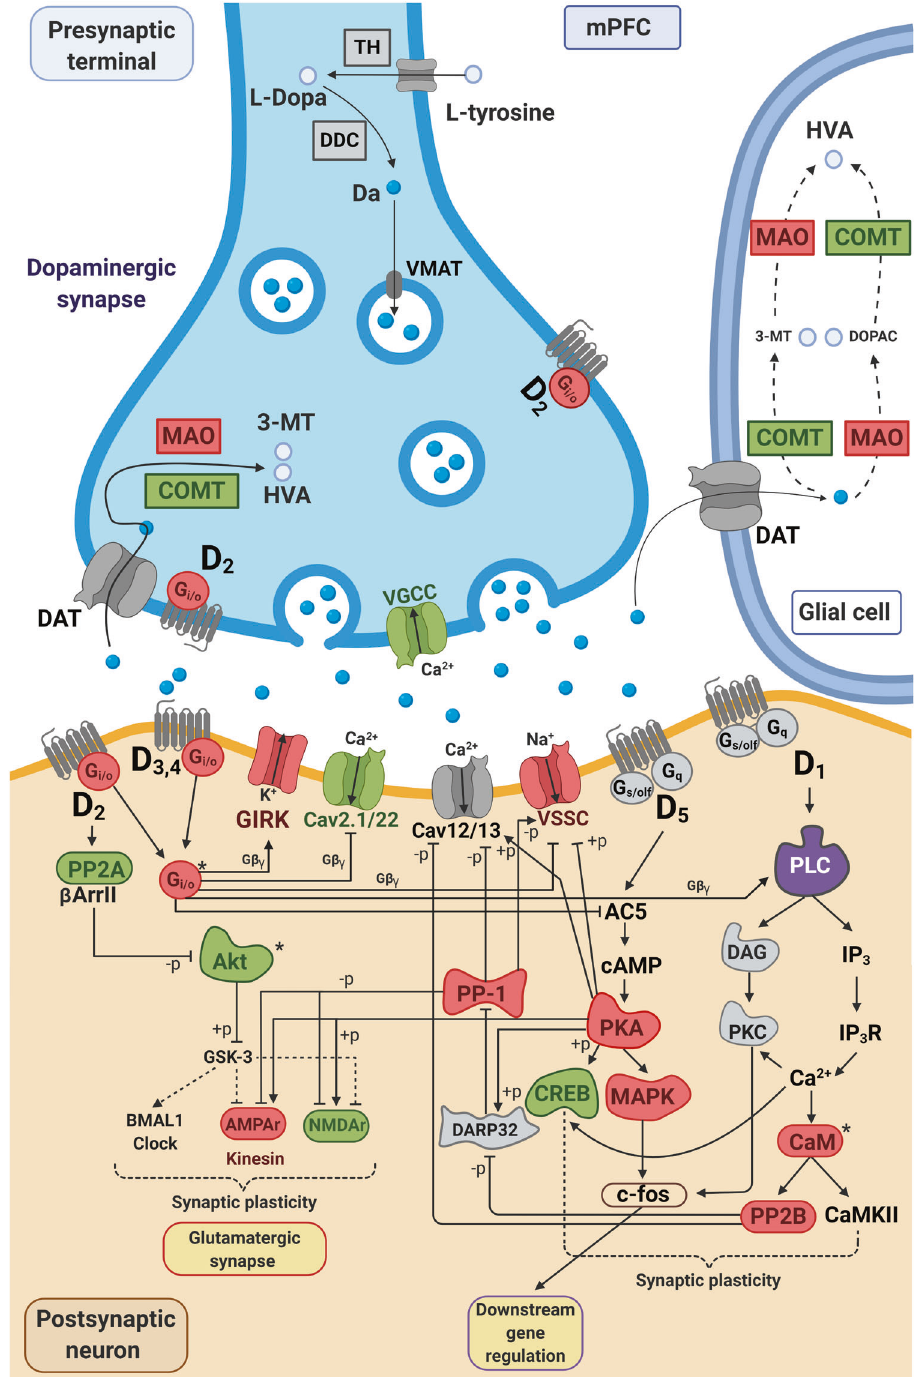
Fig. 4 Alterations in expression in the dopaminergic synapse in mPFC of Plcb1 + / − mice after cue-induced reinstatement of cocaine-seeking. Adapted from KEGG (Kyoto Encyclopedia of Genes and Genomes) pathways (mmu04728). Enriched pathway in differ- entially expressed genes in mPFC, 25 out of 131 genes in the